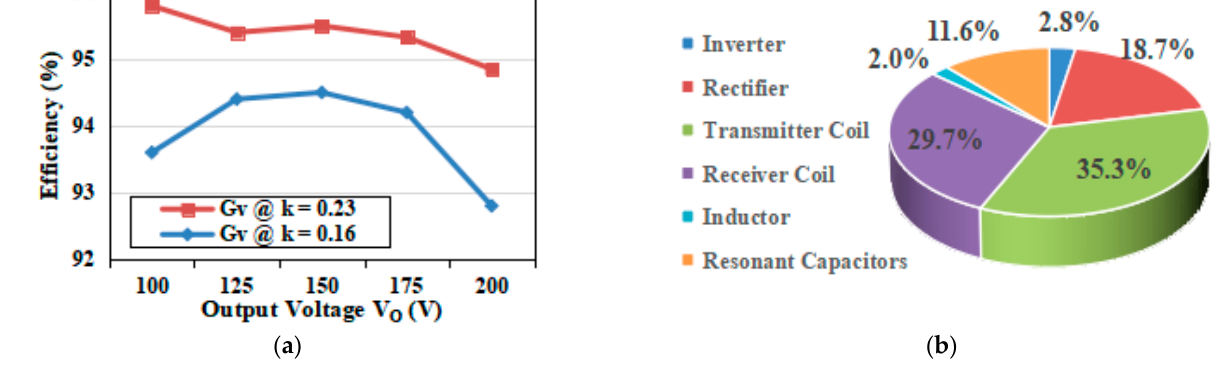
Figure 10. Measured efficiency ( a ) and power losses distribution ( b ) at 150 V, k =